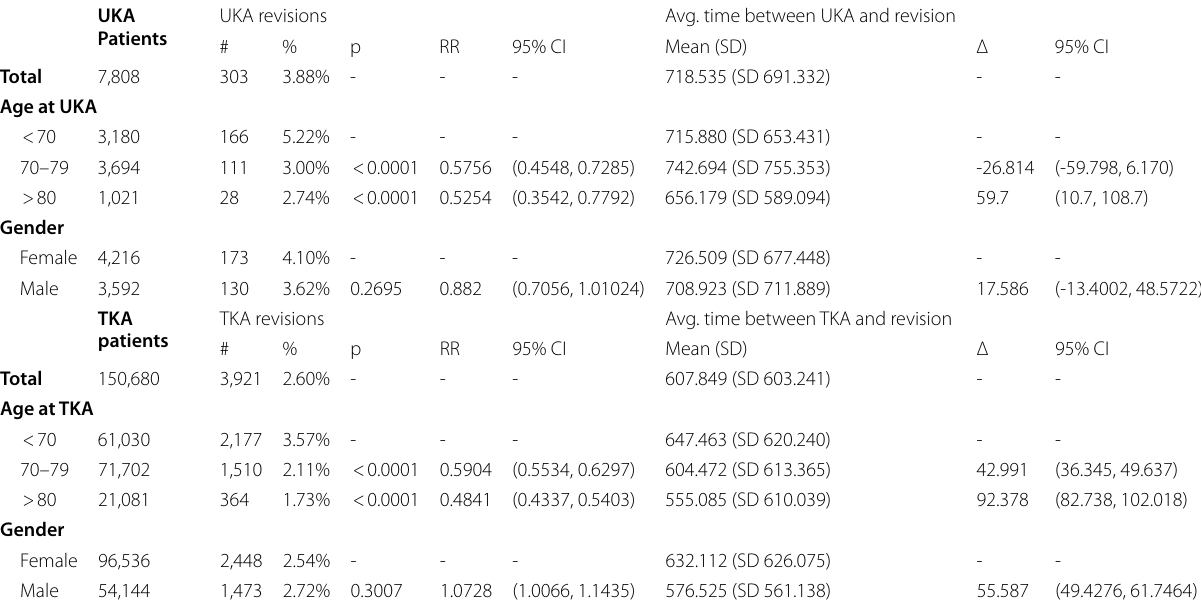
Table 5 Time until revision for UKA and TKA UKA Patients